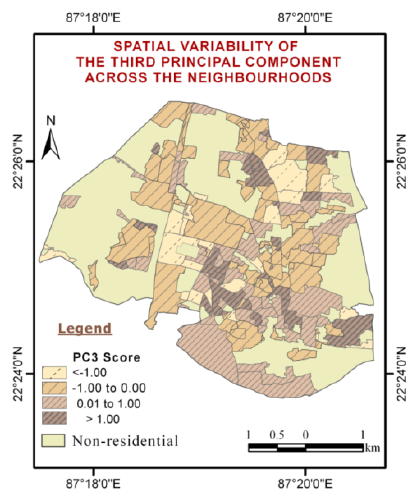
Figure 4. Third Principal Component and NHs Most important aspects like social, economic and education status are indicated by PC2. PC2 score is higher in these neighbourhoods like Najargunge, Saratpally, Vivekanandanagar (north) etc. Because in middle income neighbourhoods, size of family is small that lowers the unemployment rate.